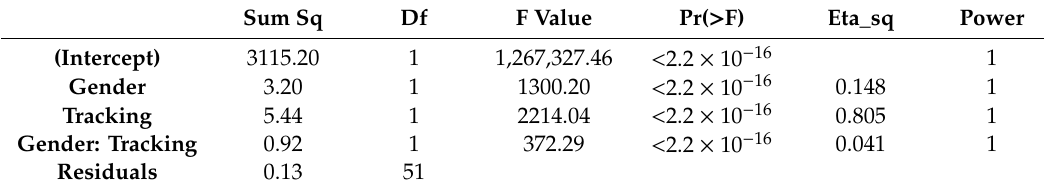
Figure 3. Boxplot for Pace per Mile (minutes per mile) indicated by Gender and Tracking type. Table 1. Type III 2-way unbalanced design ANOVA for Pace per